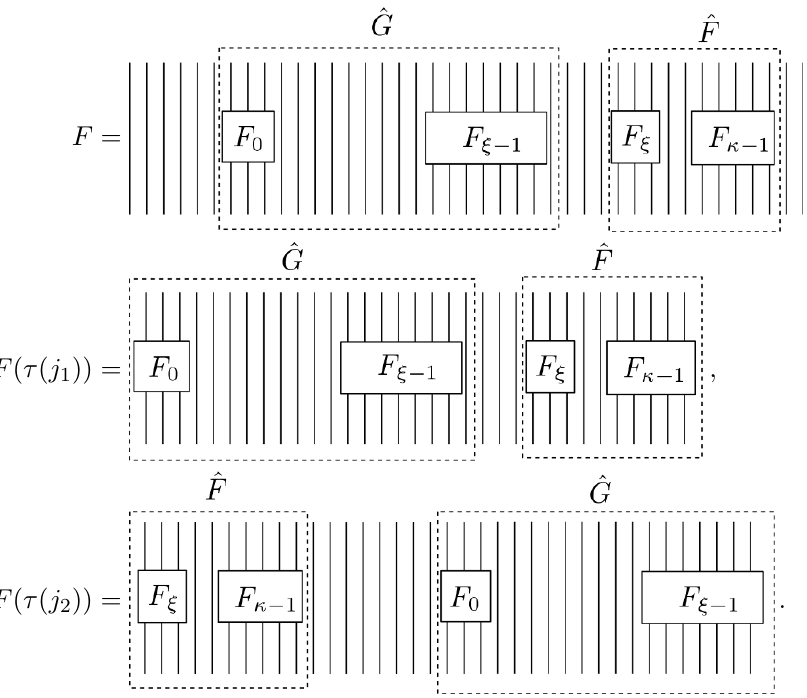
Figure 7 . Example for the operator F and the corresponding F ( (cid:28) ( j 1 )) and F ( (cid:28) ( j 2 )).